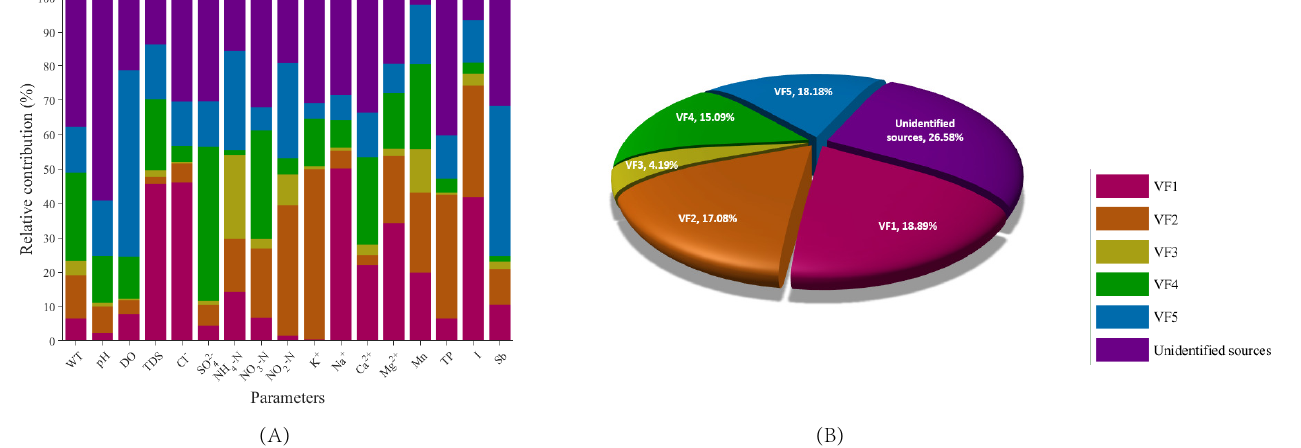
Figure 8. The contributions on the groundwater quality parameters ( A ) and average contributions ( B ) of pollution sources in the pilot promoter region of Yangtze River Delta integration demonstration zone according to the APCS-MLR